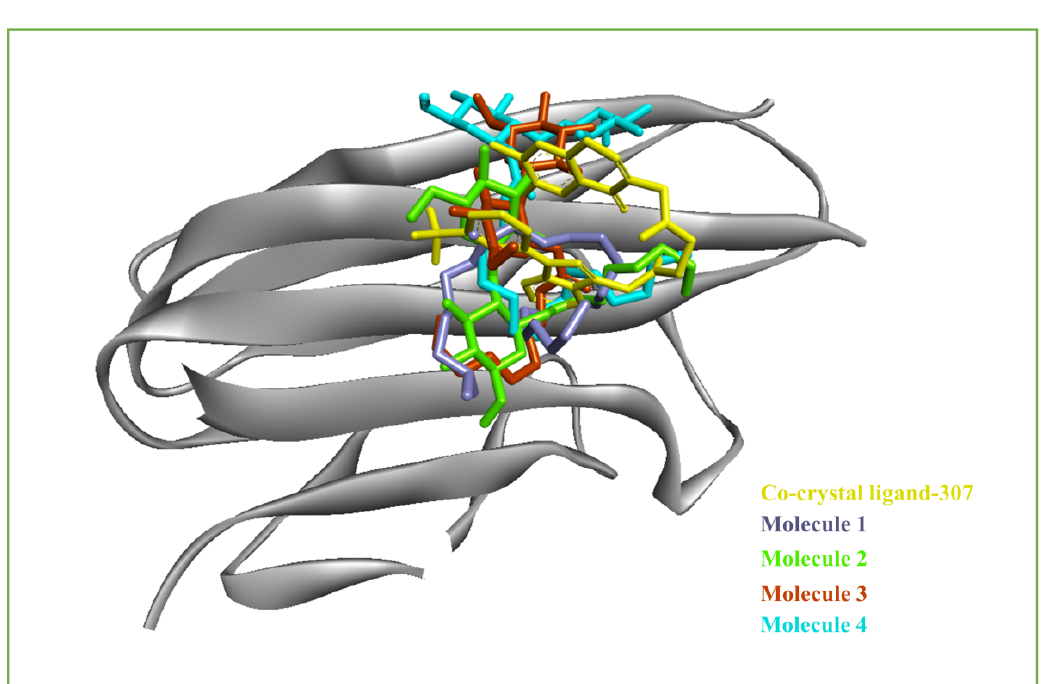
Figure 4. Superimposed conformations of the docked molecules and co-crystal ligand- 307 in the binding pocket of 2AZ5_A. The docked molecules are shown in the sticks, and the protein is shown in cartoon representation using Biovia Discovery Studio Visualizer.